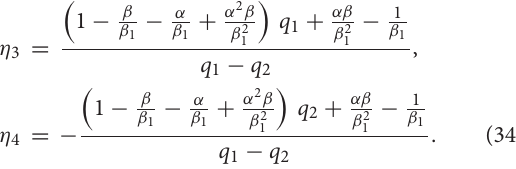
FIGURE 6 | Velocity plots showing variations in M (Newtonian